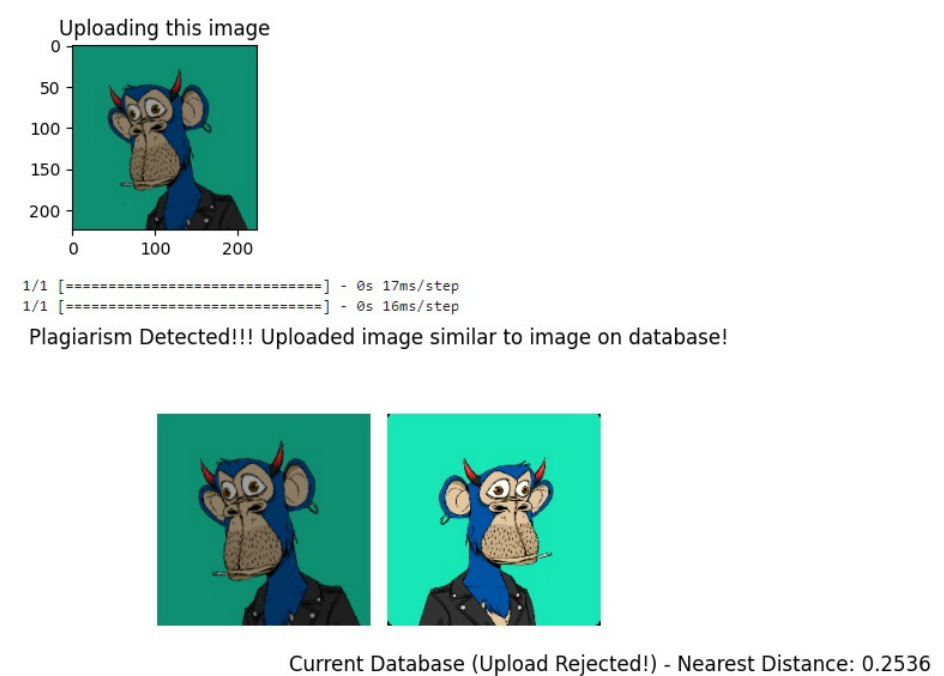
Figure 15. Simulation of detecting plagiarized NFT